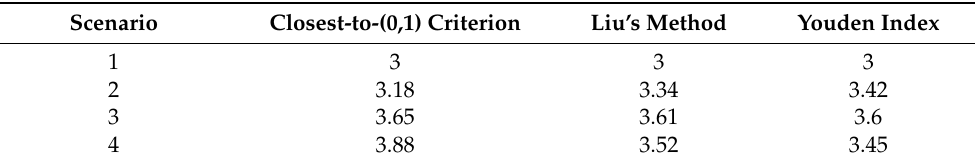
Table 1. True optimal cut-off points for all scenarios and closest-to-(0,1) criterion, Liu’s method, and Youden